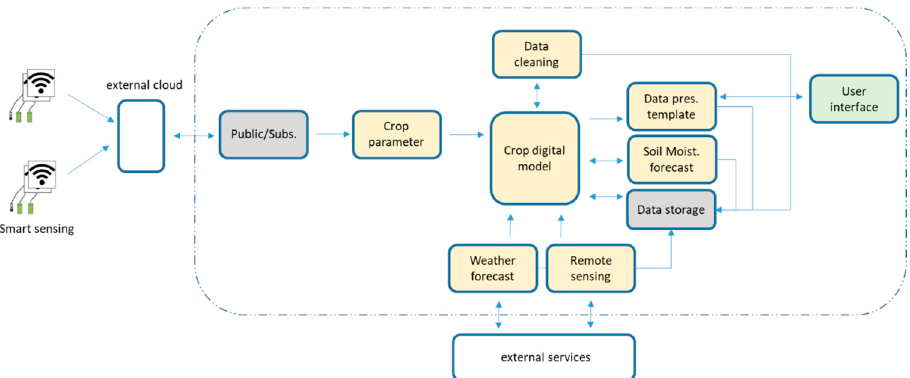
Figure 6. Dataflow diagram with an example of the organization of the General Cloud Services (GCS; grey colour) and Application Specific Services (ASS; yellow colour) within the platform for the monitoring of a cotton or rice farm.